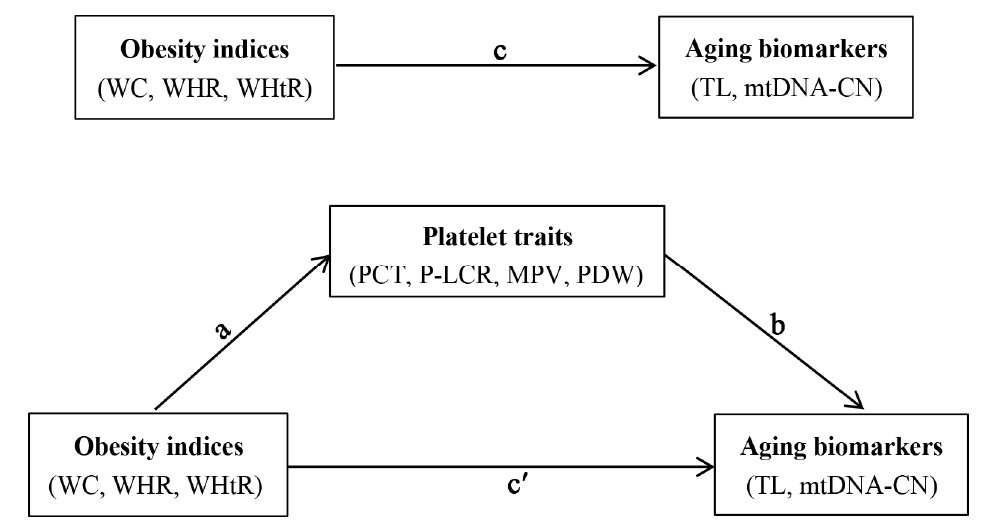
Figure 1. Conceptual mediation model of the associations between obesity indices, platelet traits and aging biomarkers. WC: waist circumference; WHR: waist-to-hip ratio; WHtR: waist-to-height ratio; PCT: plateletcrit; P-LCR: platelet large cell ratio; MPV: mean platelet volume; PDW: platelet distribution width; TL: telomere length; mtDNA-CN: mitochondrial DNA copy number. Path a indicates the effect of obesity indices (WC, WHR, and WHtR) on platelet traits (PCT, P-LCR, MPV, and PDW); path b indicates the effect of platelet traits on aging biomarkers (TL and mtDNA-CN); path c reflects the total effect of obesity indices on aging biomarkers; path c ′ reflects the effect of obesity indices on aging biomarkers when controlled for platelet traits.